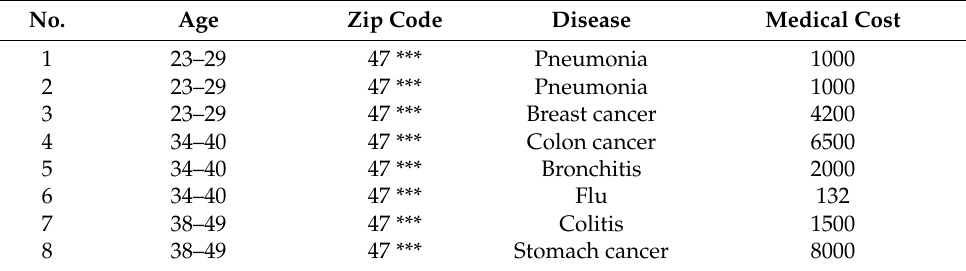
Table 2. A skewness attack version of Table 1.